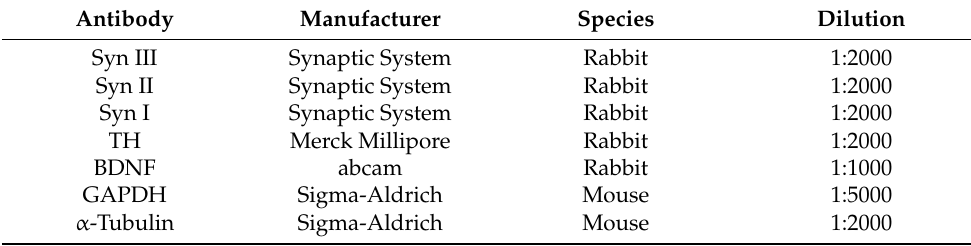
Table 1. List of the primary antibodies used in the WB studies and of their working